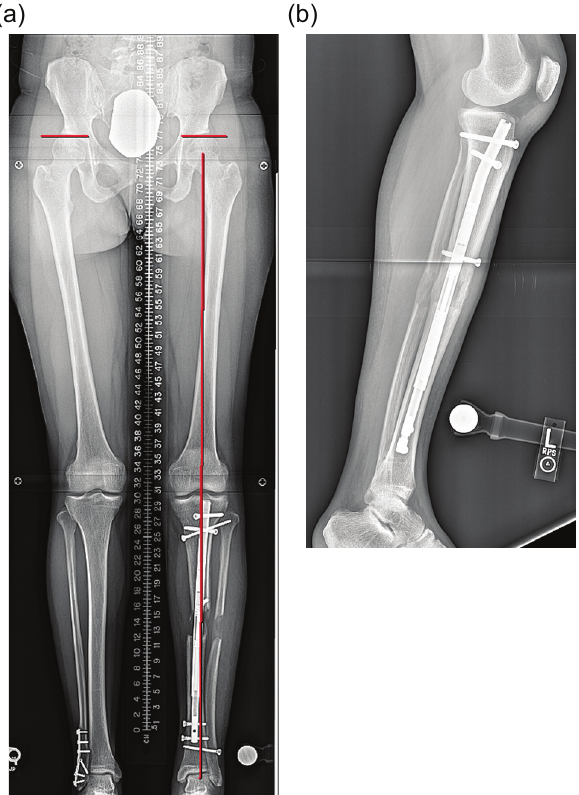
Figure 15. (a) The X-rays shown in Figures 15a and 15b are a continuation of the patient presented in Figures 10a and 10b. The end of distraction long-standing radiograph shows equal limb length and ideal alignment. (b) A lateral radiograph shows interval healing of the regenerate and ideal sagittal alignment.